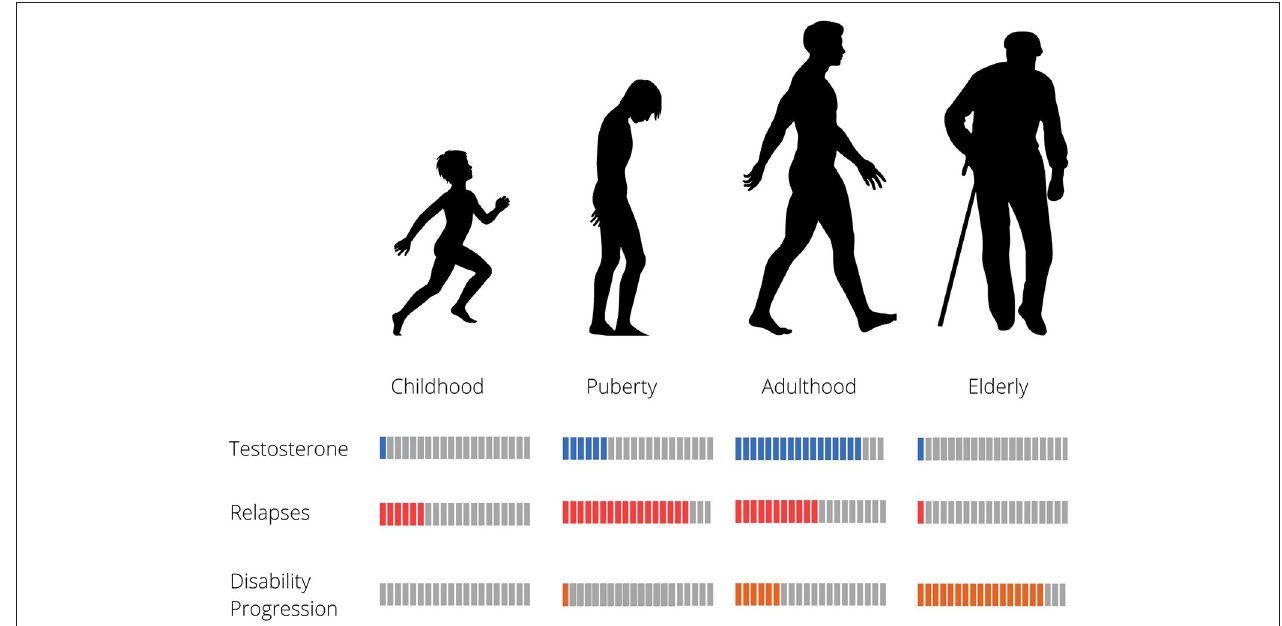
FIGURE 1 | Relapse rate, disability progression and testosterone levels in relation to age in MS males.